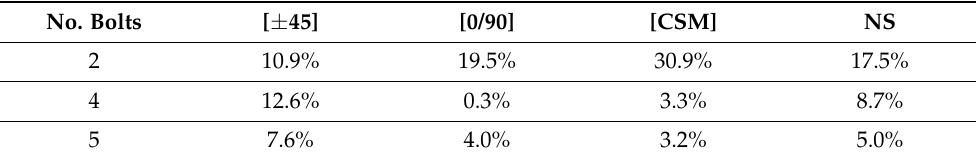
Table 7. Comparison of the strengthening effect of 3d end -distance specimens to 2d end distance specimens.